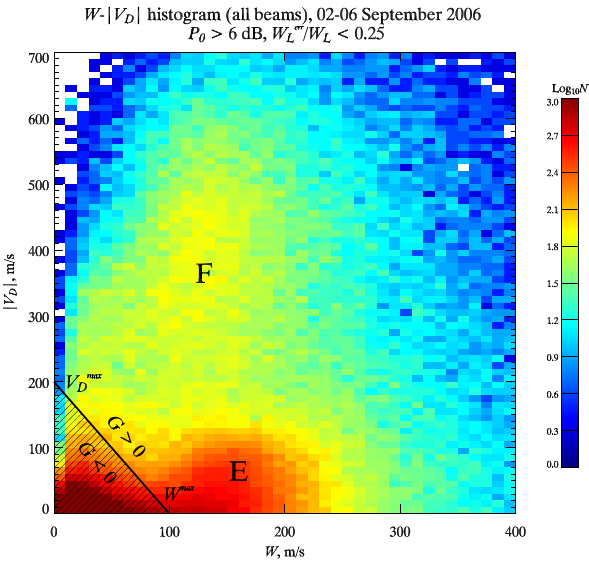
Fig. 6. Graphic illustration of the sea/mixed scatter rejection crite- rion used in this